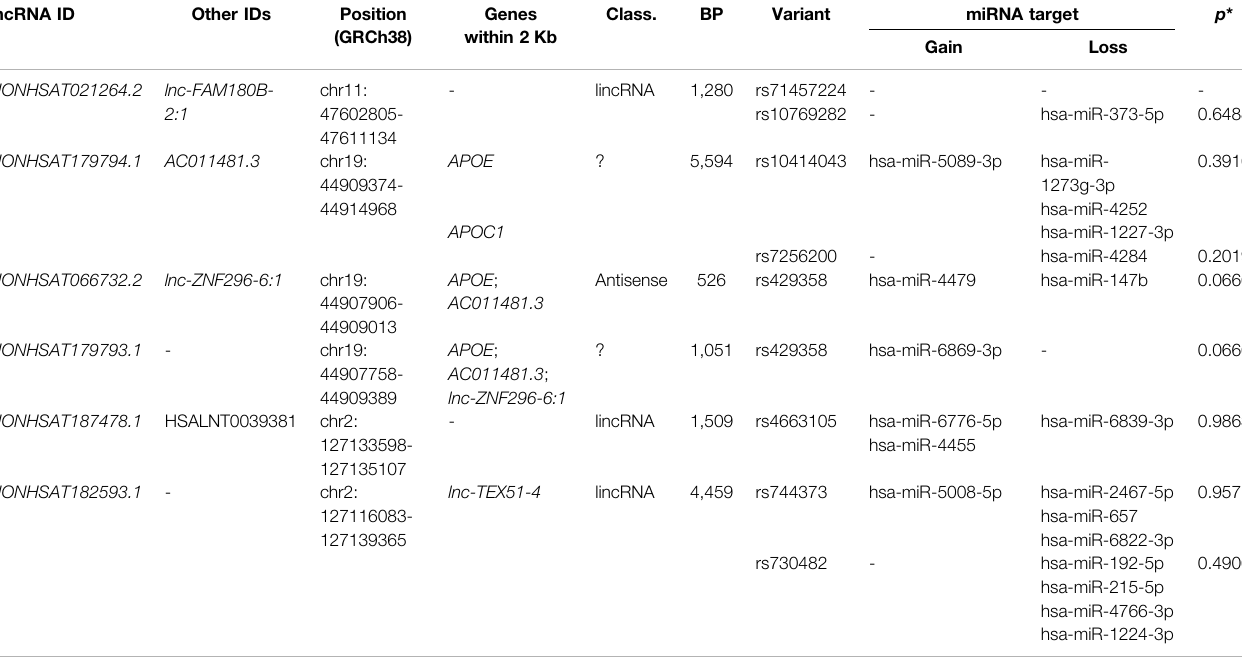
TABLE 5 | Characterization of lncRNAs potentially involved in AD. lncRNA